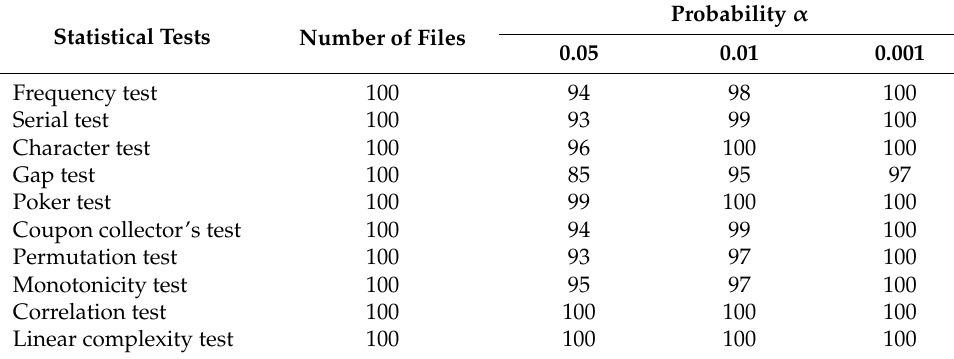
Table 7. The results of the statistical tests with a probability value of α .